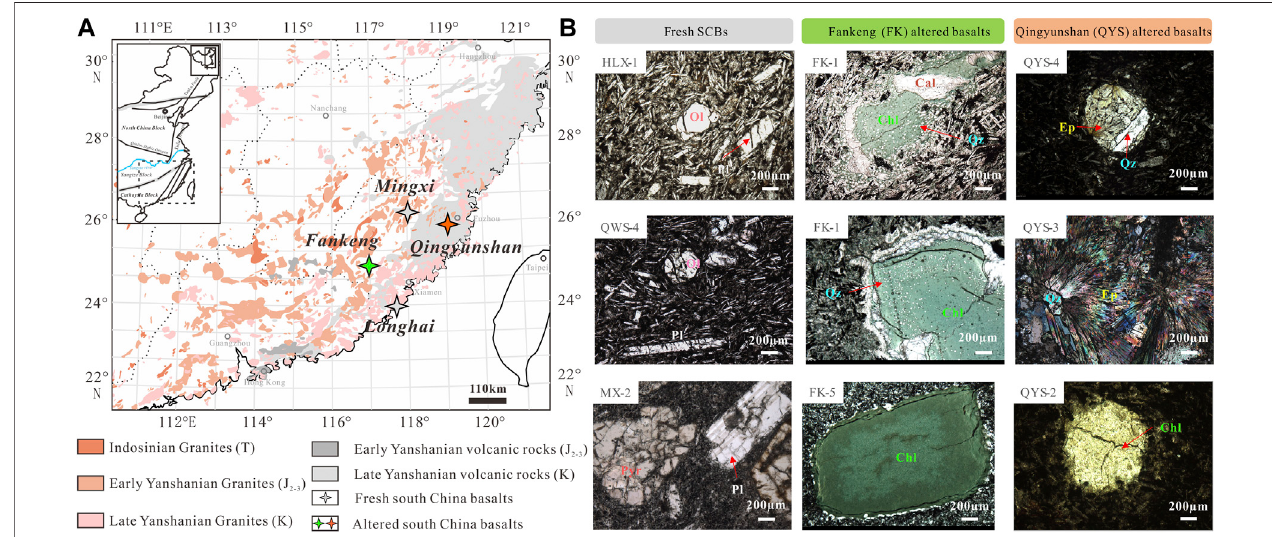
FIGURE 1 | (A) Simpli fi ed geological map of the distribution of granite-volcanic rocks in South China (modi fi ed from the work of Zhou et al. (2006)). (B) Polarized photomicrograph of main mineral phases in fresh and altered basalts (QYS and FK basalts). Ol, olivine; Pyr, pyroxene; Pl, plagioclase; Chl, chlorite; Cal, calcite; Qz, quartz; and Ep,